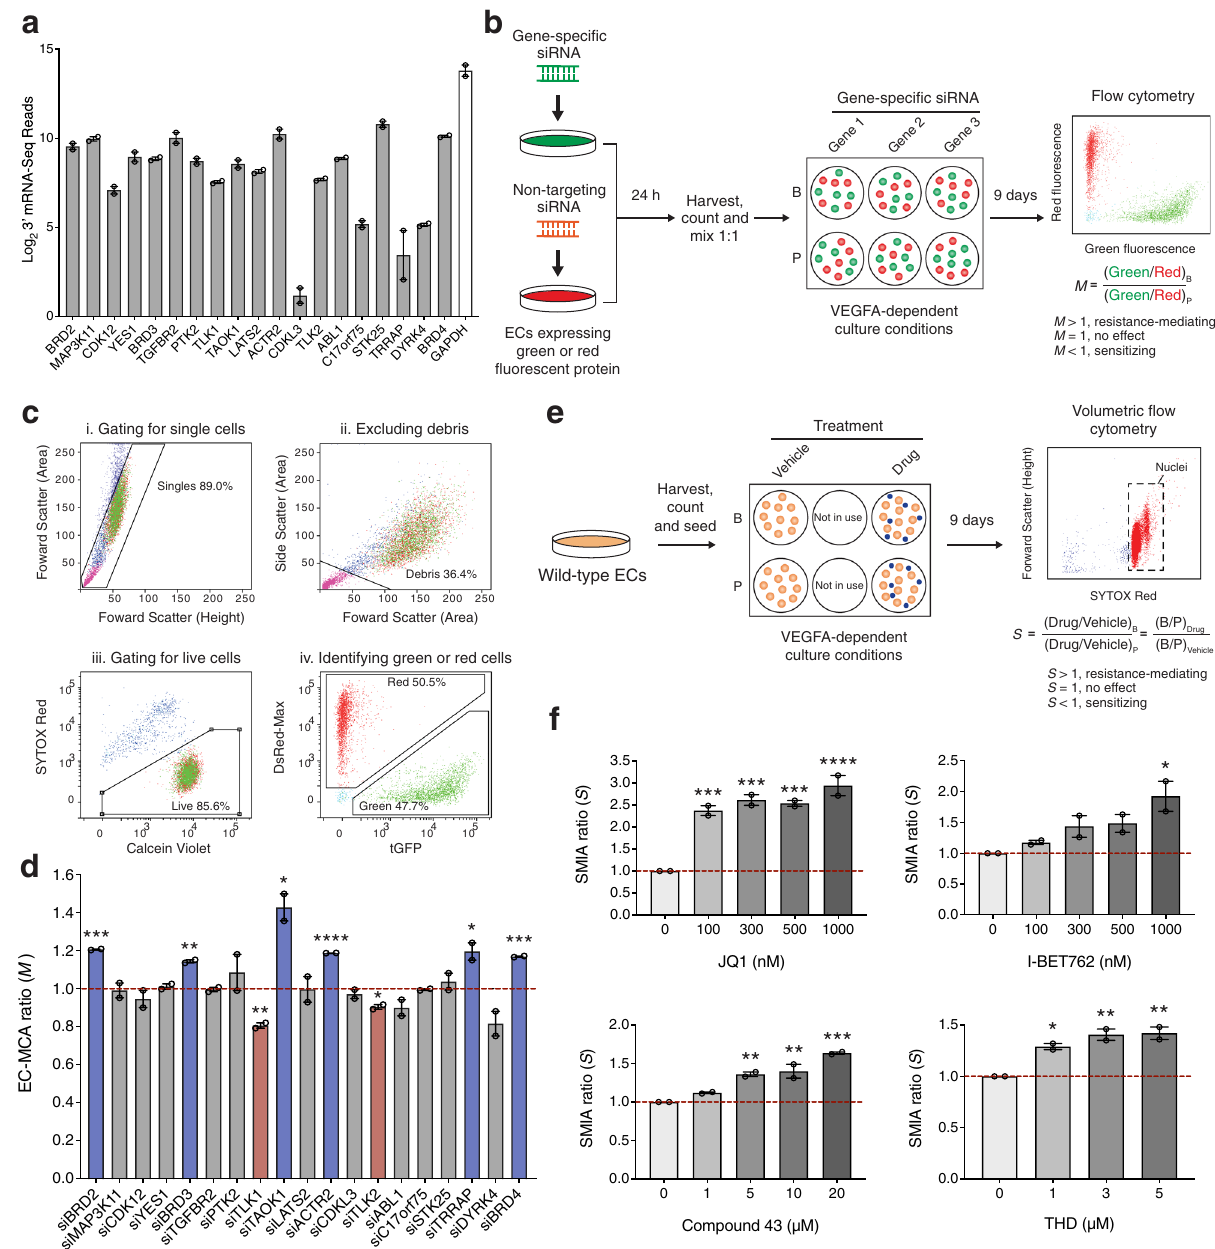
Fig. 3 Validation of screen candidate genes. a Baseline expression of the candidate genes and BRD4 was assessed in ECs cultivated in microcarrier-based culture using RNA-Seq. Gene expression is represented by log 2 3 ′ mRNA-Seq reads. Expression of GAPDH is used as a reference for relative expression (white bar). All genes were highly expressed except CDKL3 . Error bars represent ± SEM ( n = 2 independent experiments). b Schematic representation of the EC-MCA (see Methods for further details). c Gating strategy of fl ow cytometry-based determination of M . Total number of events per sample was 10,000. The percentages shown are those of the parent population. d EC-MCA analysis of the effect of siRNA-mediated knockdown of the candidate genes and BRD4 . A ratio of 1 (red dotted line) indicates no effect of siRNA on the EC response to bevacizumab. M > 1, resistance-mediating effect. M < 1, sensitization. Blue or red bars represent the resistance-mediating or sensitizing candidates identi fi ed from the EC-MCA, respectively. Error bars represent ± SEM ( n = 2 independent experiments). * P value < 0.05; ** P value < 0.01; *** P value < 0.001; **** P value < 0.0001 (versus M = 1, two-tailed unpaired t test). e Schematic representation of the SMIA (see Methods for further details). f Effects of pan-BETi, JQ1, and I-BET762; TAOK kinase inhibitor, compound 43; and TLK1 kinase inhibitor, THD were assessed using the SMIA. A ratio of 1 (red dotted line) indicates no effect on the EC response to treatment. S > 1, resistance-mediating effect. S < 1, sensitization. Error bars represent ± SEM ( n = 2 independent experiments). *, adjusted P value < 0.05; **, adjusted P value < 0.01; ***, adjusted P value < 0.001; ****, adjusted P value < 0.0001 (versus S = 1, one-way ANOVA with Dunnett ’ s multiple comparison test